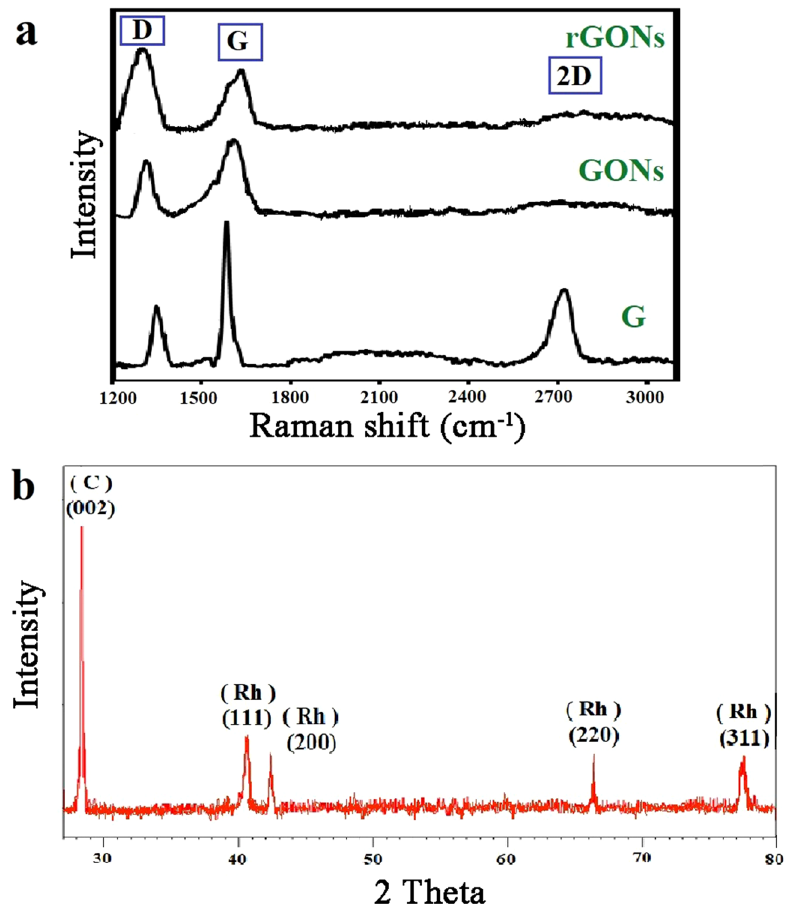
Figure 3: ( a ) Raman spectra of bare, GON - modi fi ed, and rGON - modi fi ed graphite electrodes and ( b ) XRD pattern carbon - supported Rh -